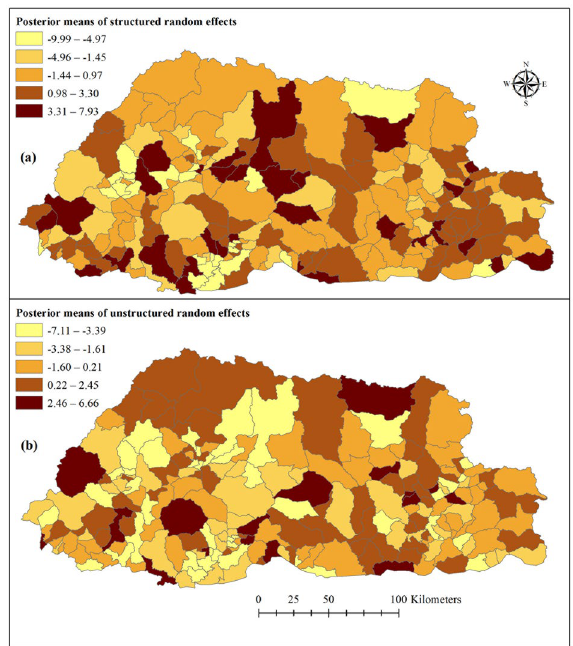
Figure 3. Spatial distribution of posterior means of structured ( a ) and unstructured random effects ( b ) of common cold in Bhutan, January 2010–2018.